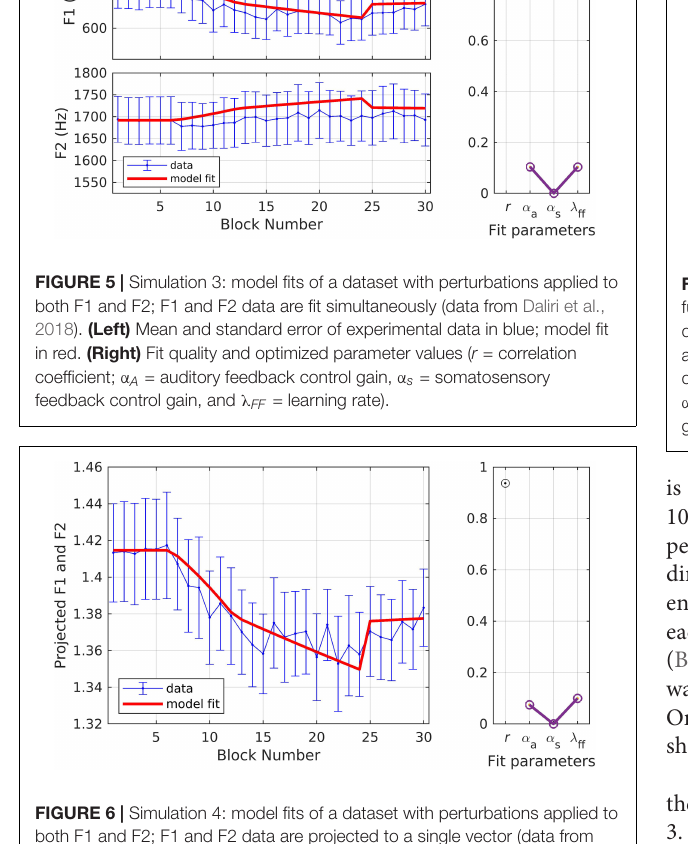
FIGURE 6 | Simulation 4: model fits of a dataset with perturbations applied to both F1 and F2; F1 and F2 data are projected to a single vector (data from Daliri et al., 2018). (Left) Mean and standard error of experimental data in blue; model fit in red. (Right) Fit quality and optimized parameter values ( r = correlation coefficient; α A = auditory feedback control gain, α s = somatosensory feedback control gain, and λ FF = learning rate).